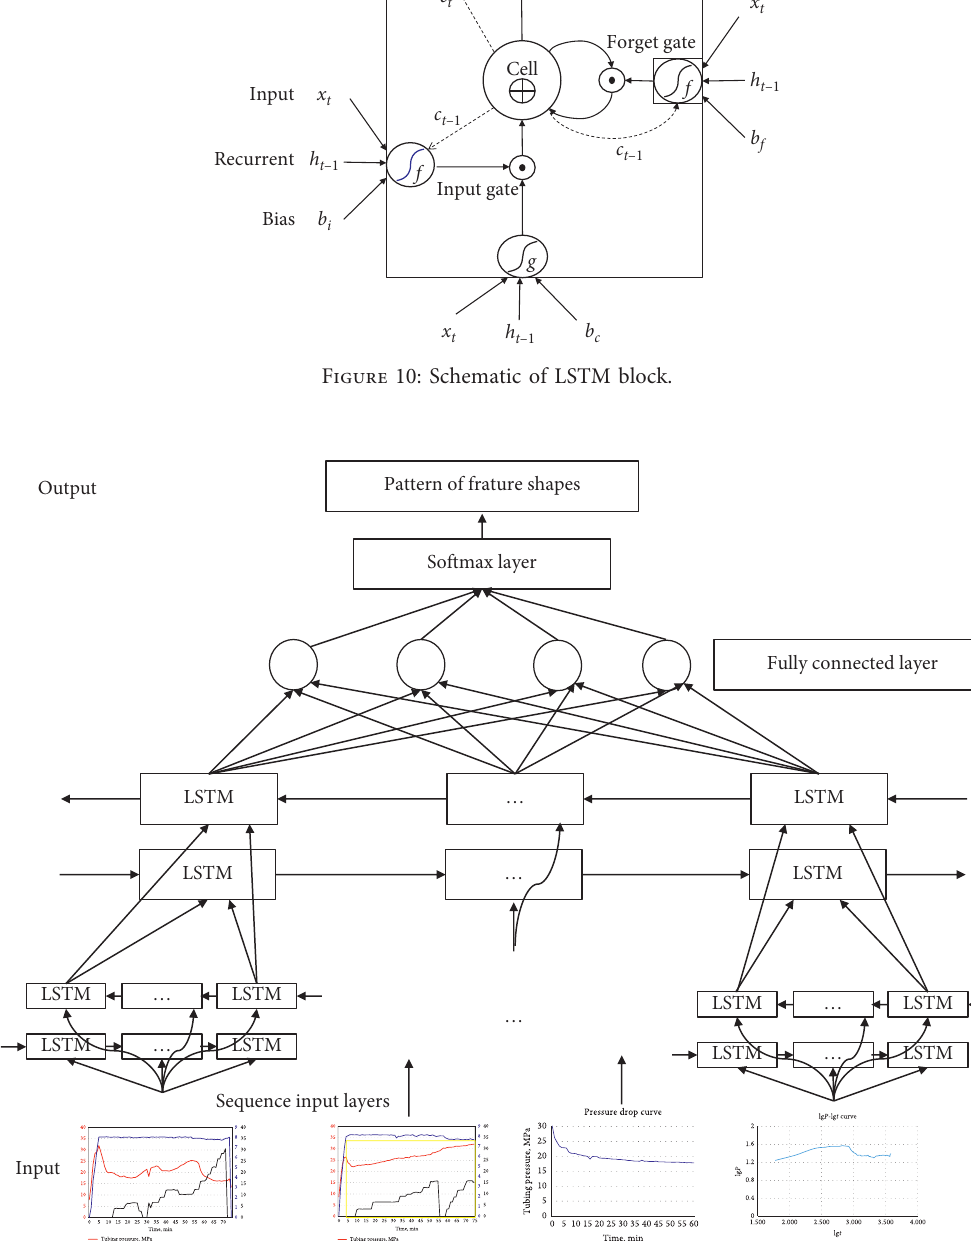
Figure 11: The hierarchical Bi-LSTM for the pattern recognition of the fracture shapes in CBM